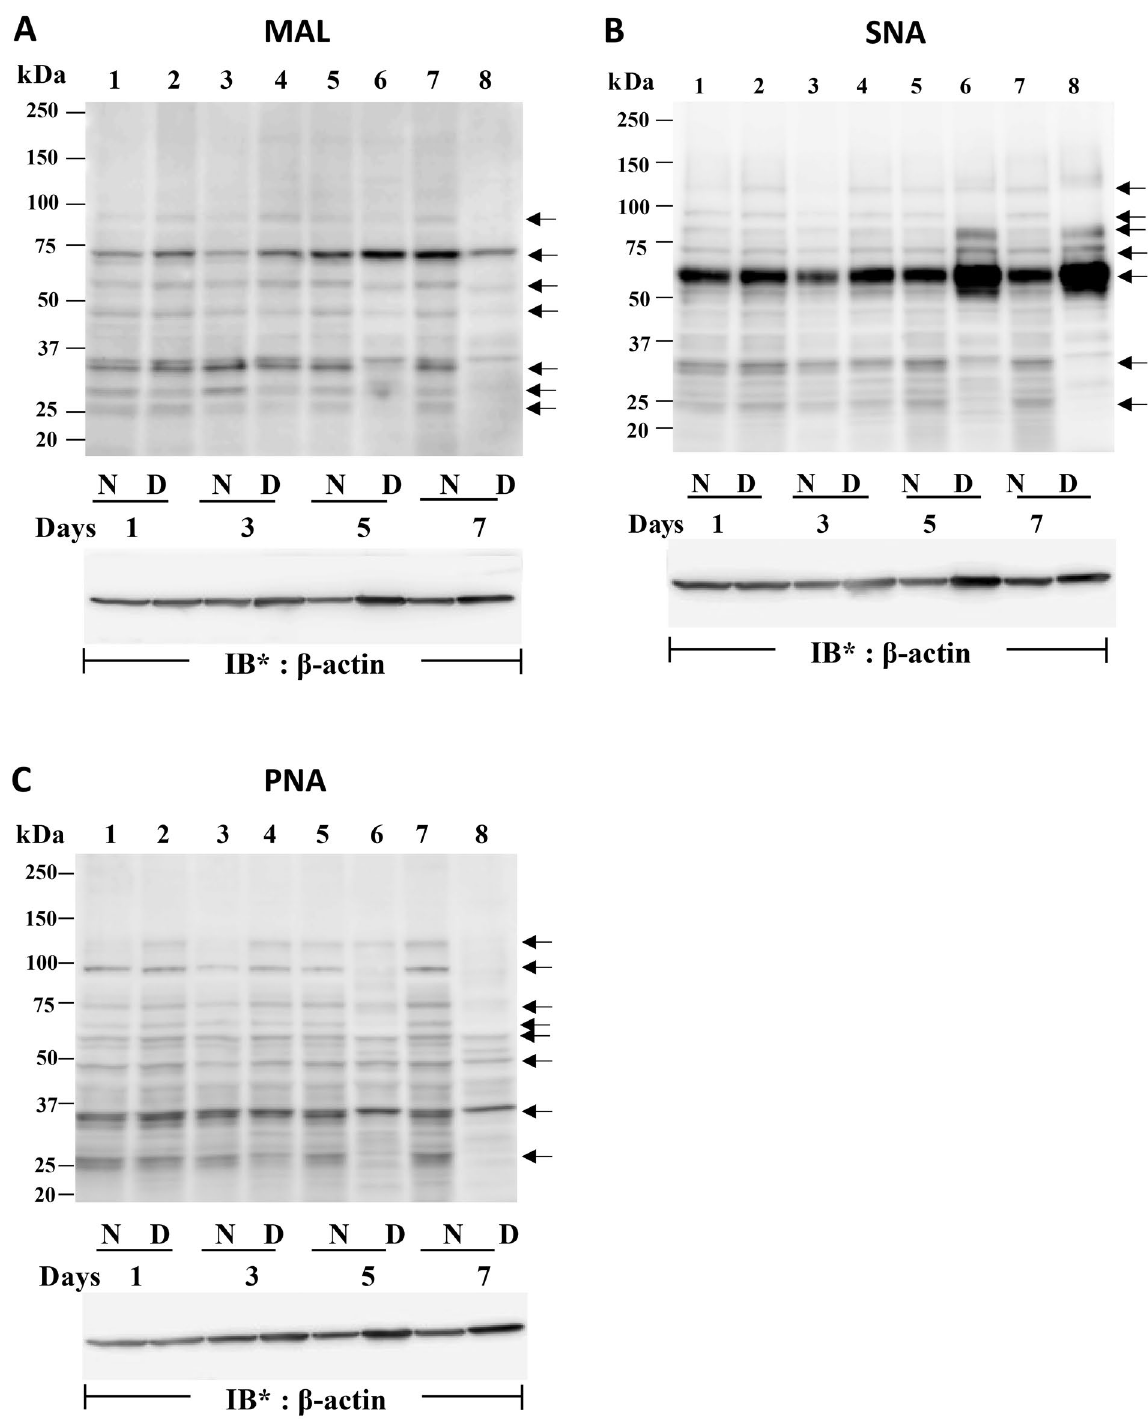
Figure 7. Changes in HL60 Cell Sialylation During Differentiation. ( A–C ) HL60 cells were cultured for 1, 3, 5, and 7 days in the presence of DMF or medium alone, lysed, and the lysates, at 50 µg total cellular protein/ lane, were resolved by SDS-PAGE, transferred to PVDF, and probed with biotinylated MAL ( A ), SNA ( B ), or PNA ( C ), each followed by incubation with HRP-conjugated streptavidin and ECL reagents. To control for protein loading and transfer, blots were stripped and reprobed for β-actin. IB = immunoblot; IB* = immunoblot after stripping. MW in kDa indicated on left. Arrows on right indicate unidentified bands in which sialylation changes over time. Each lectin blot is representative of 3 independent experiments. Cropped lectin blot images are